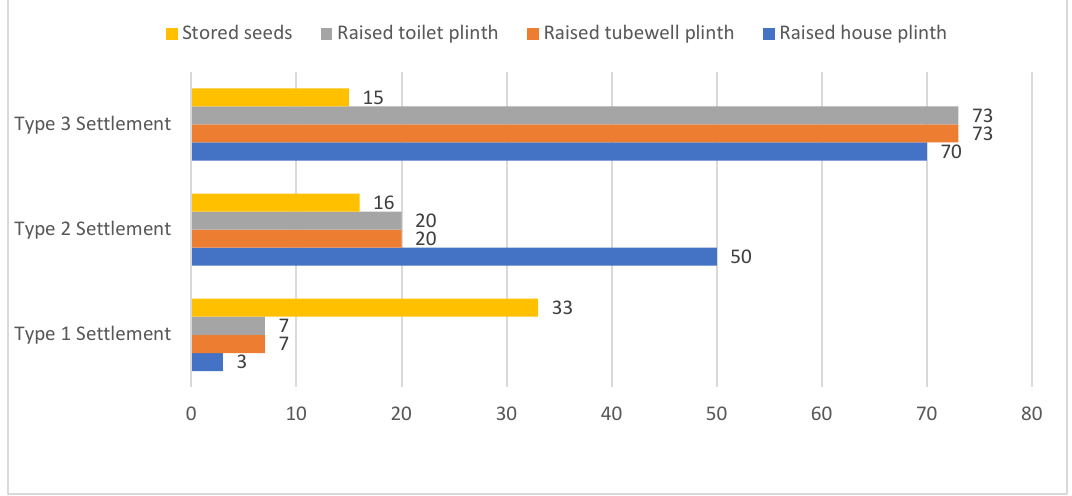
Figure 3. Status (%) of structural and non-structural preparedness measures taken by respondent in all three settlements (n = 90). Source: survey.